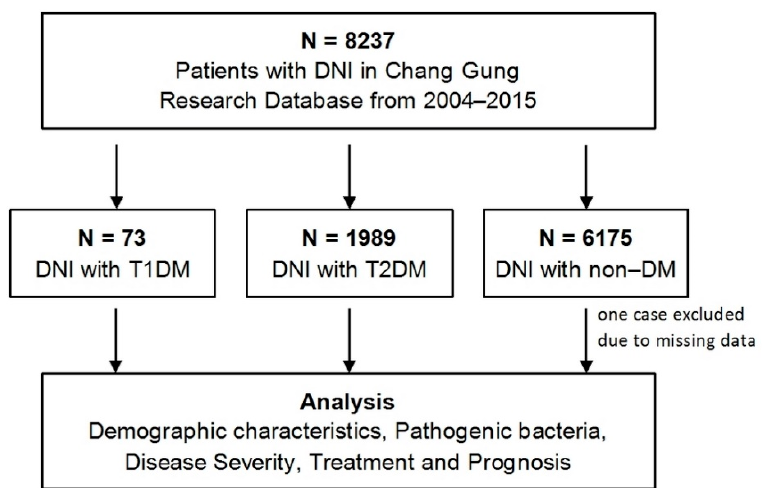
Figure 1. Enrolment and classification schema of DNI cases. Abbreviations: DNI, deep neck infection; T1DM, type 1 diabetes mellitus; T2DM, type 2 diabetes mellitus.